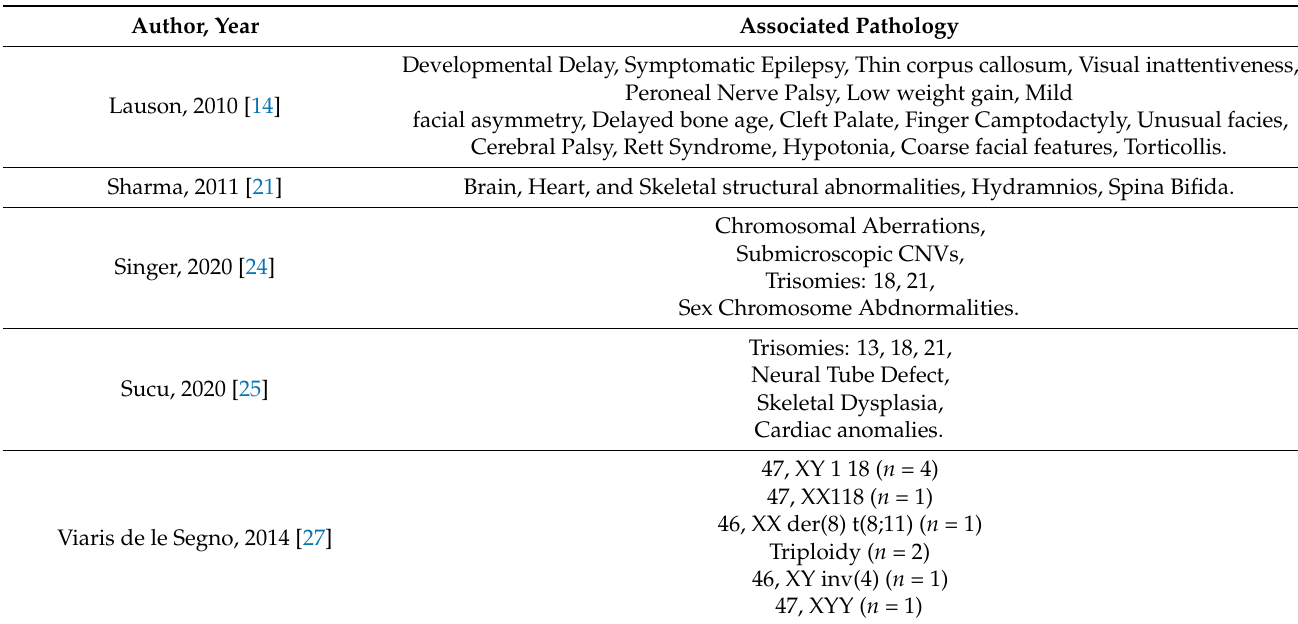
Table 2. Primary author, year of publication and associated pathologies of the studies